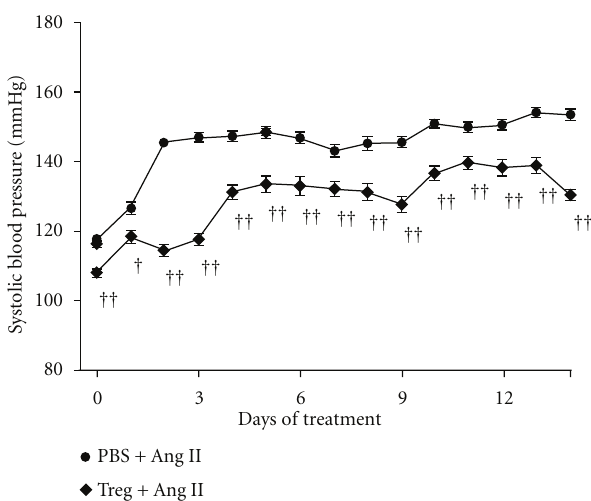
Figure 1: T-regulatory lymphocyte (Treg) adoptive transfer pre- vented angiotensin II (Ang II)-induced hypertension. Systolic blood pressure (SBP) was evaluated by telemetry in mice chronically infused with Ang II and pretreated with PBS or Treg. Mean daily SBP data are presented. Data are expressed as means ± SEM. † P < 0,05 e †† P < 0,001 versus PBS + Ang II with n = 24 data points per day for each 3 to 4 mice. Adapted from